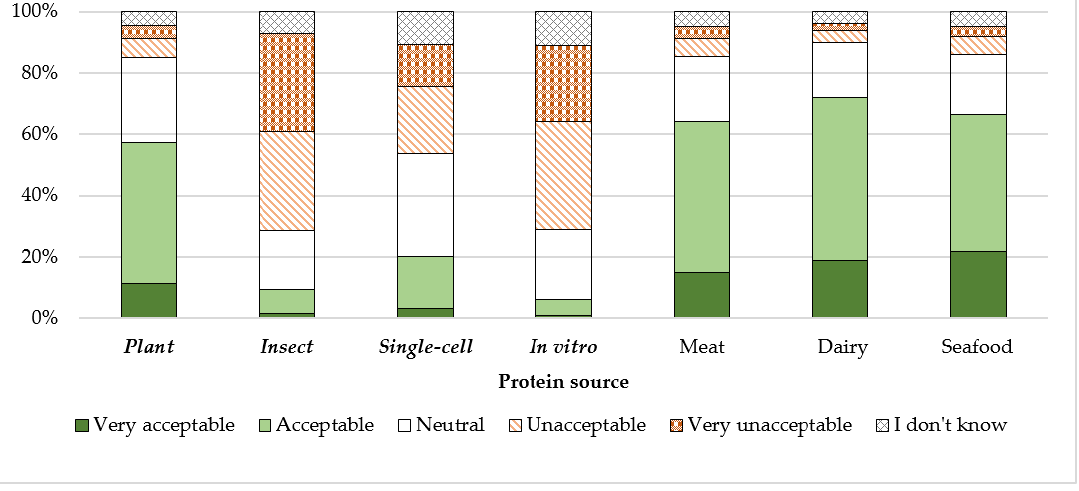
Figure 1. Level of acceptance to eat food products containing alternative, more sustainable protein sources (italicized and in bold) and other dietary protein sources in adults aged 65 years and older from five EU countries (%, n = 1825).